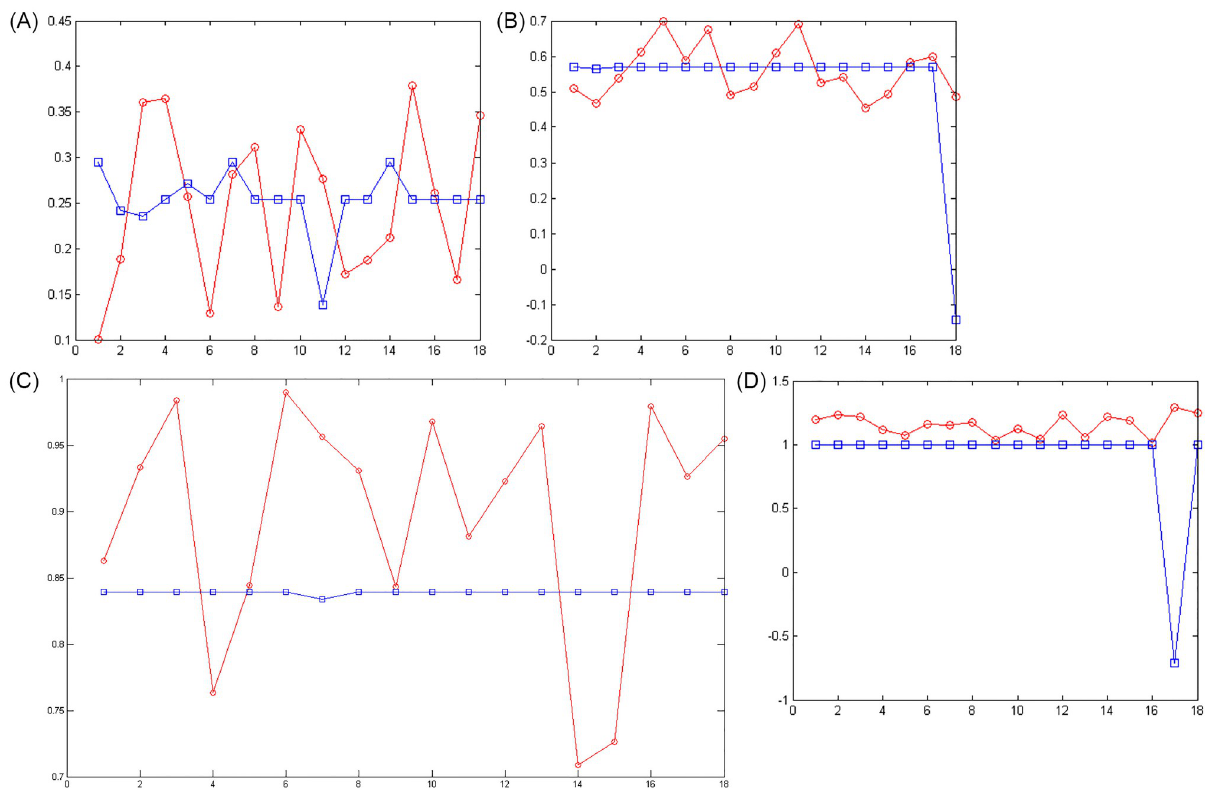
Fig 6. The distance of the obtained answer (blue chart) in each generation change in ANN-PSO compared to the real answer (red chart) in test samples: (Fig 6A)[0.1, 0.4], (Fig 6B)[0.4, 0.7], (Fig 6C)[0.7, 1] and (Fig 6D)[1, 1.3] range.